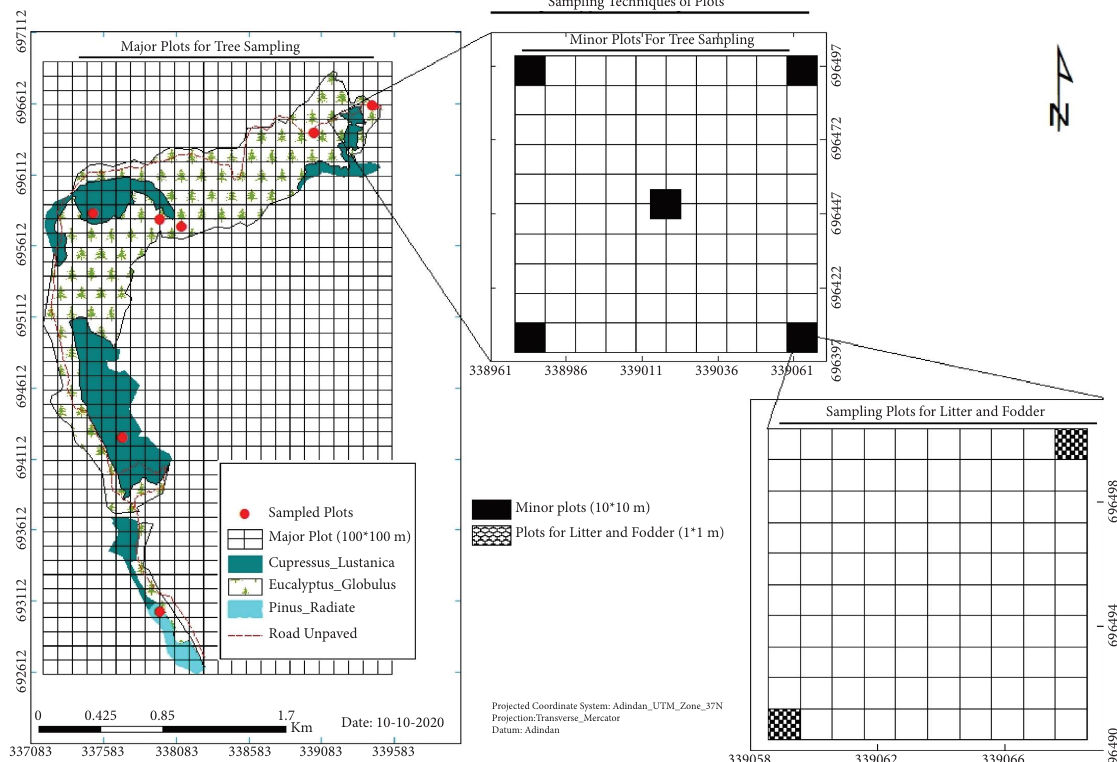
Figure 2: Sampling design of major plots (above left), minor plots (above middle), and small plots (below right) designed for collecting litter data (source: own survey map,